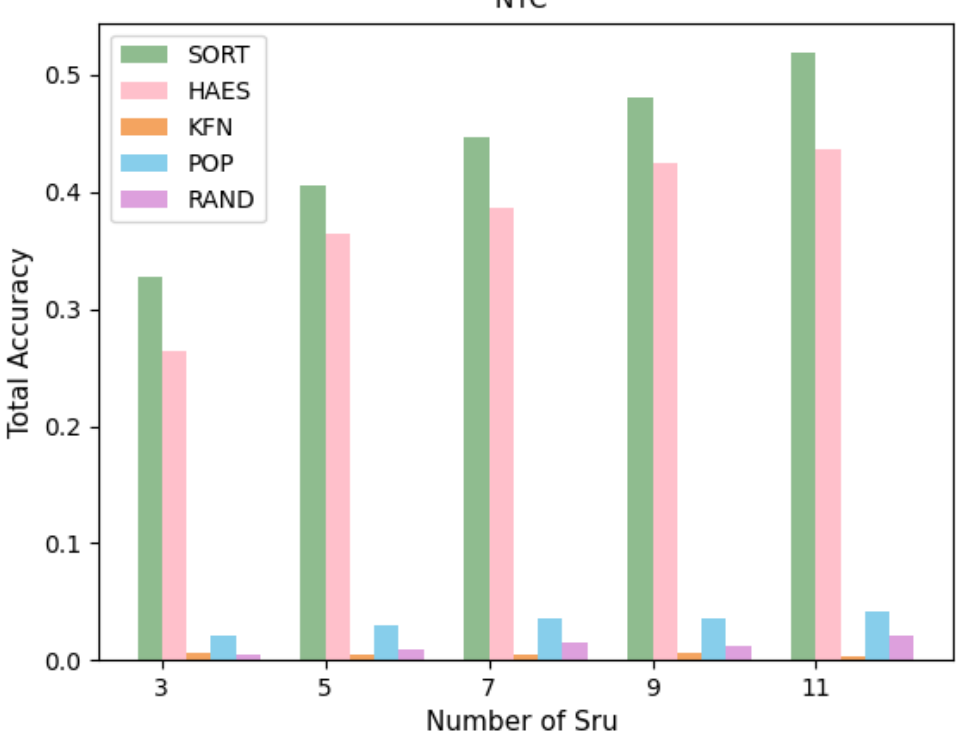
Figure 4. Total accuracy with New York